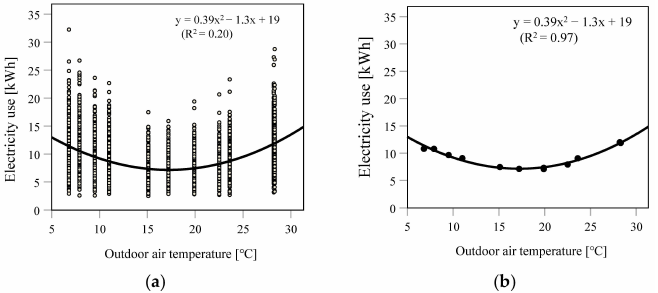
Figure 9. Relationship between the electricity use and the outdoor air temperature: ( a ) monthly mean value of each flat (n = 3648); ( b ) monthly mean value (n = 12).